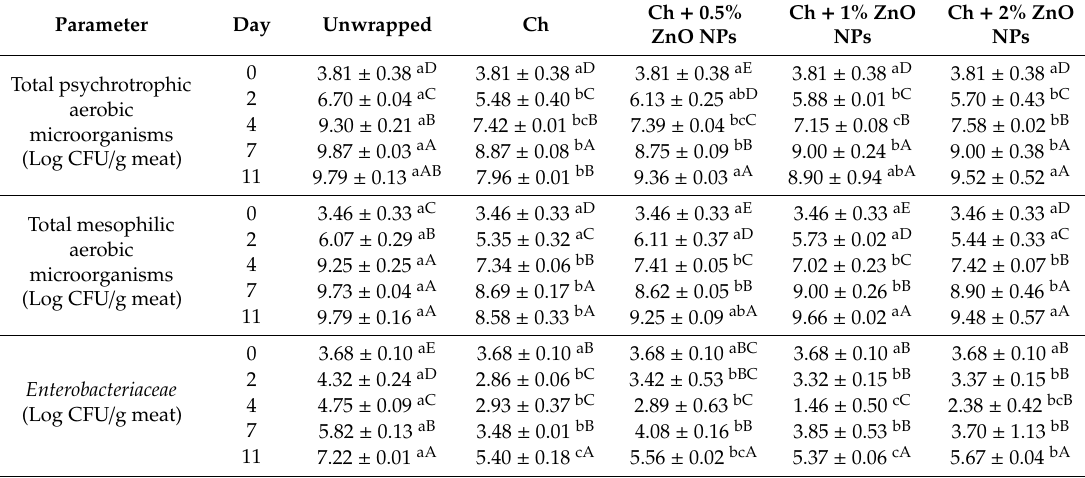
Table 2. Summary of the microbiological study of the meat over the storage